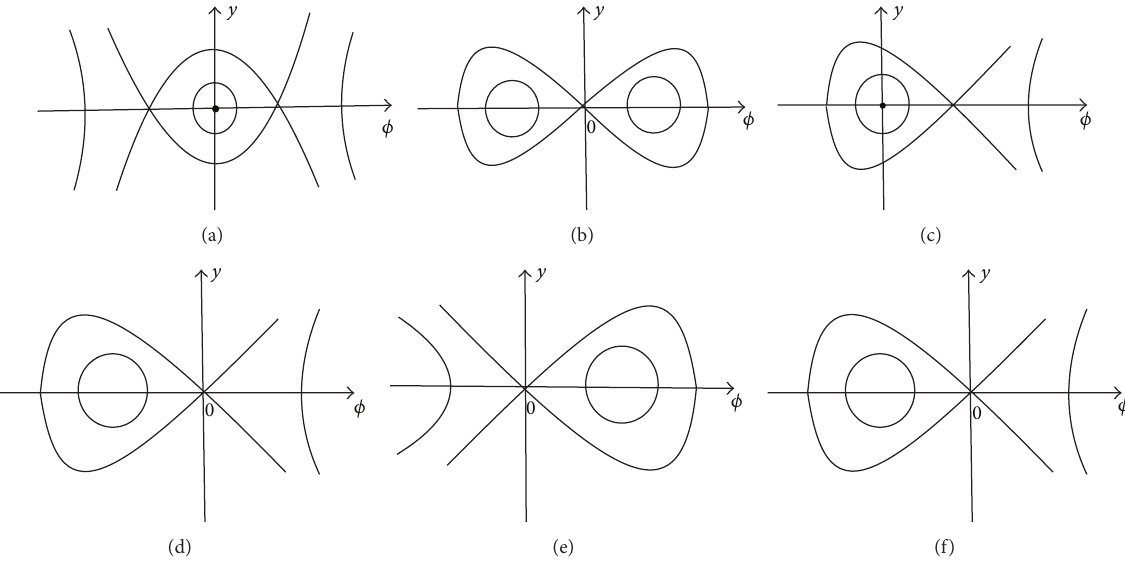
Figure 1: The phase portraits of Sy. (16). When 𝑝 − 𝑞 is even and 𝑐 > 0 , (a) and (b) are the phase portraits of system (16) for 𝑝 > 𝑞 and 𝑝 < 𝑞 , respectively. When 𝑝 − 𝑞 is odd, (c)–(f) are the phase portraits of system (16) for 𝑝 > 𝑞 and 𝑐 > 0 , 𝑝 > 𝑞 and 𝑐 < 0 , 𝑝 < 𝑞 and 𝑐 > 0 , 𝑝 < 𝑞 and 𝑐 < 0 ,